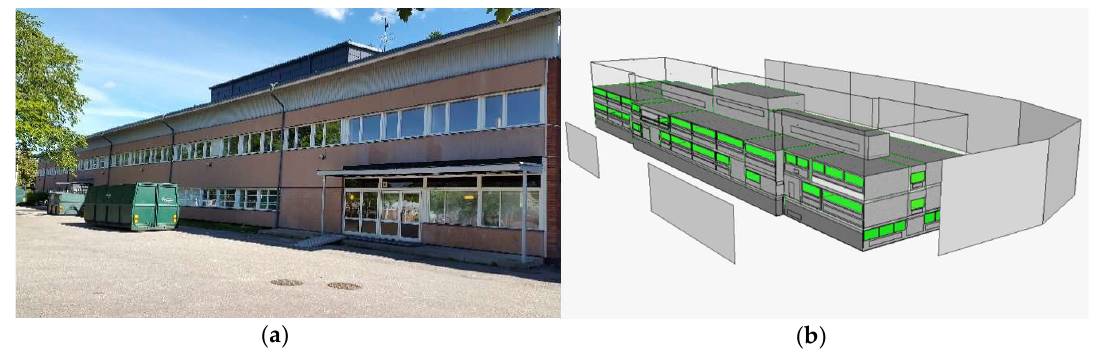
Figure 1. The school building, 97 m length, 18 m width, and 9 m height above the ground and the building energy simulation (BES) model, including shading objects such as trees shown in ( a ) and in ( b ) in form of screens.